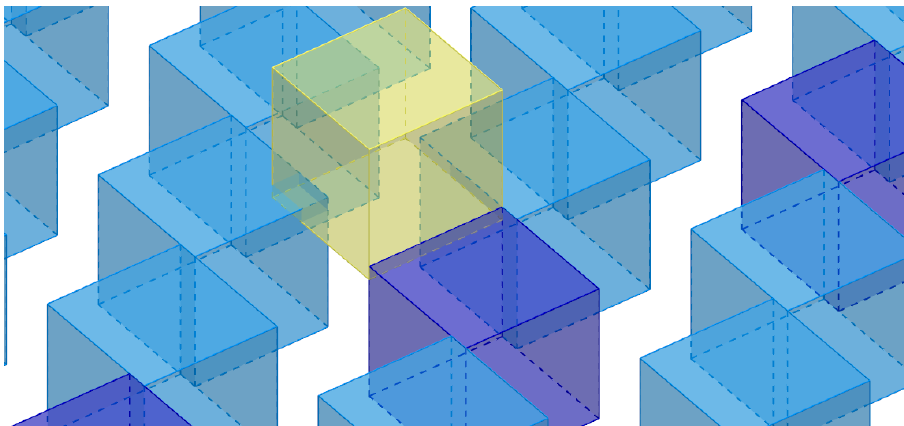
is 1 in yellow. We see that if 2